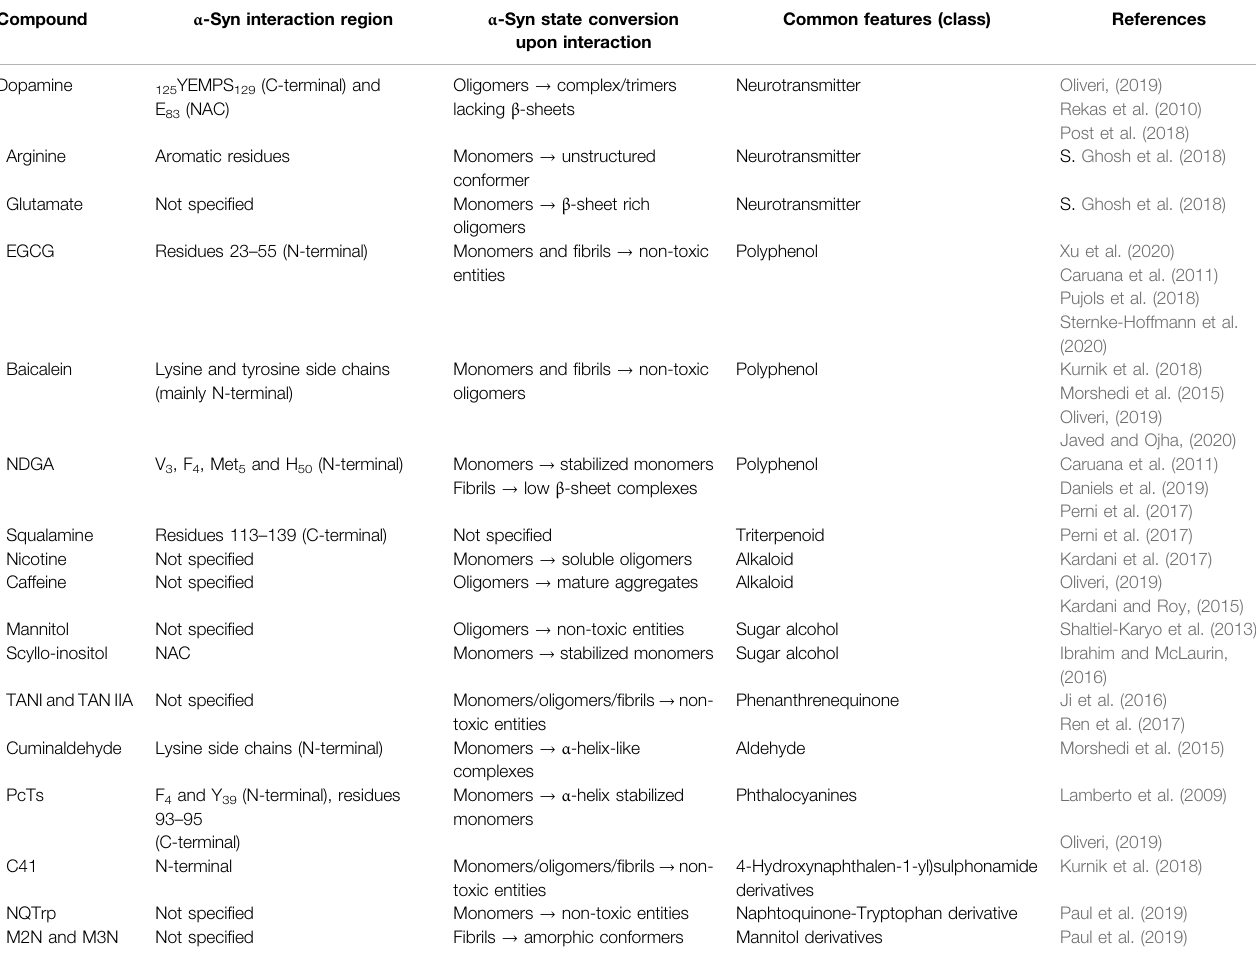
TABLE 3 | Reported endogenous and exogenous small molecules interactions with monomeric and aggregated states of α